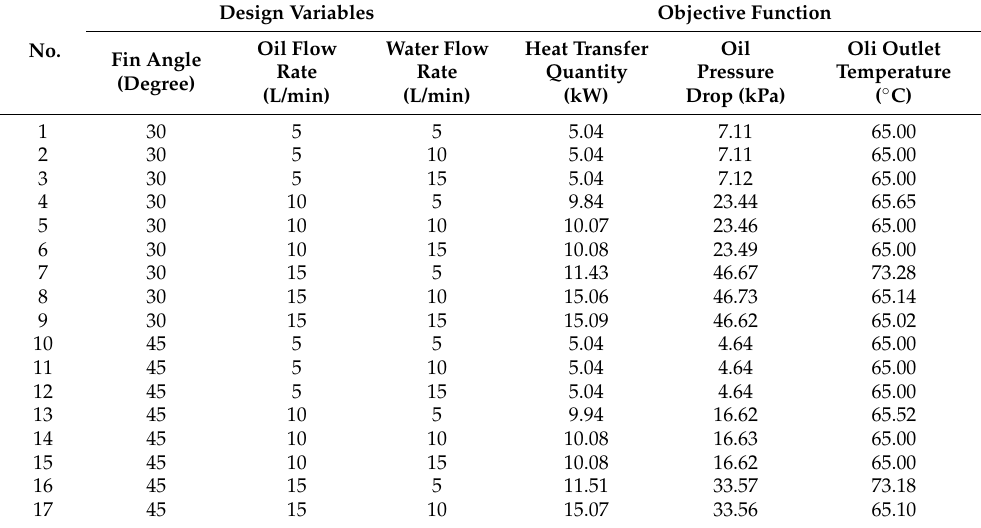
Table 6. Simulation